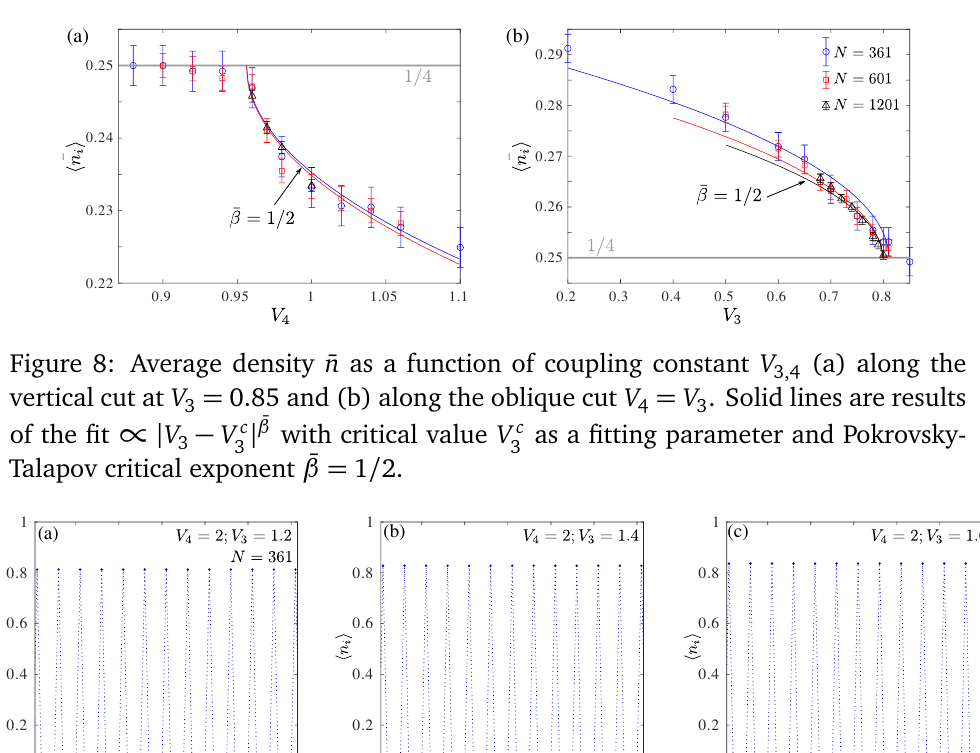
Figure 9: Local density profile for three different points inside the period-5 phase. Change of the dominant wave-vector from q = 2 π/ 5 ( V = 2, V = 1.2) is reflected with the pronounced change of curvature of the local ( V 4 3 density between the main period-5